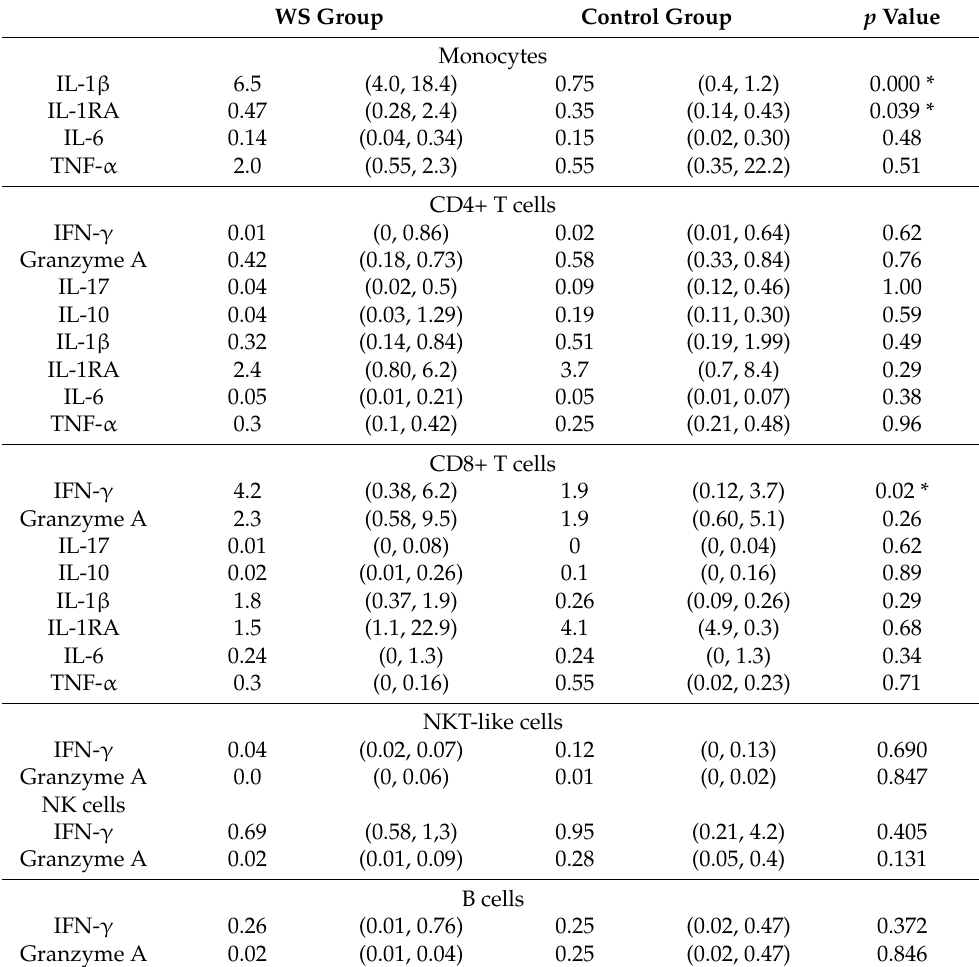
Table 2. Comparison of intracellular cytokine levels between patients with West syndrome and the control